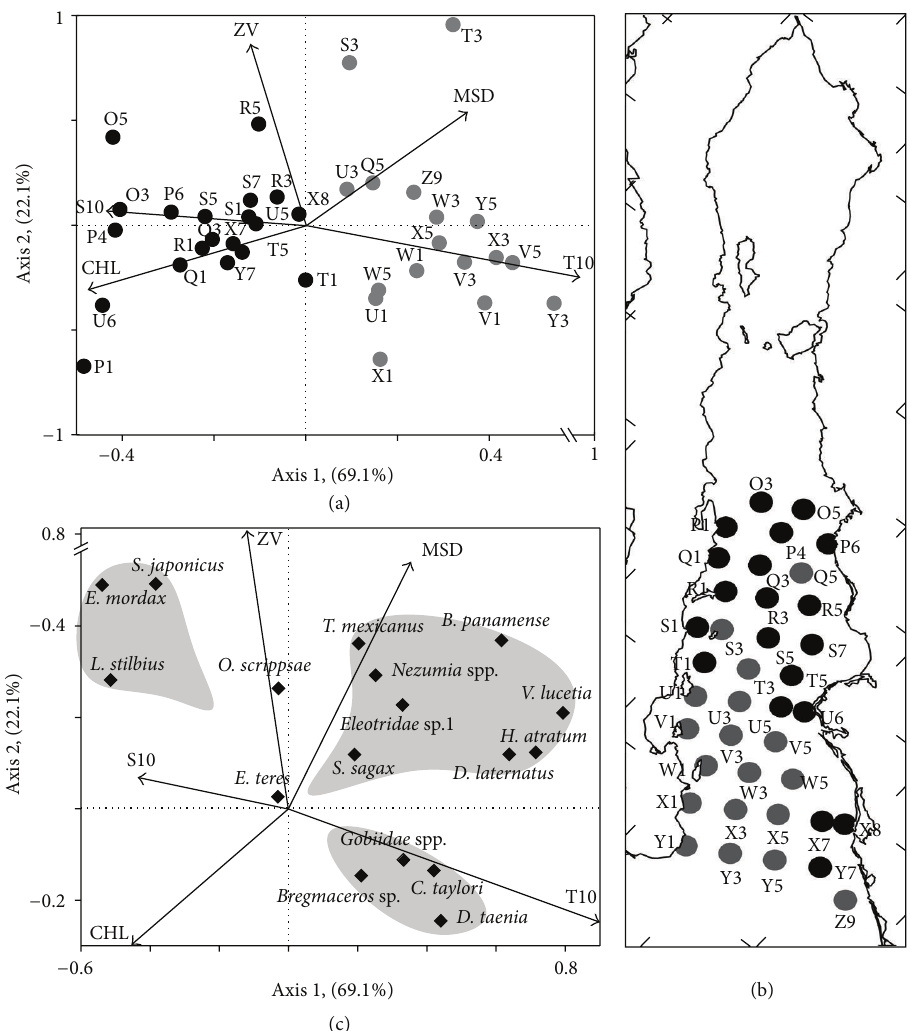
Figure 7: Classification and ordination analysis: March. (a) RDA biplot of stations environment, black circles = MaG1; grey circles = MaG2. (b) Distribution of stations groups resulting from RDA. (c) RDA biplot species